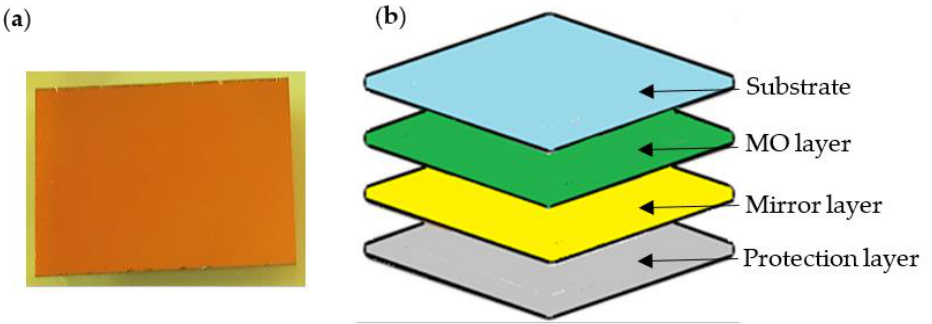
Figure 8. Magneto-optical sensor; ( a ) the photo of the A-type MO sensor in the protective packaging. ( b ) schematic showing the functional layers of the Magneto-Optical Indicator Film (sensor).